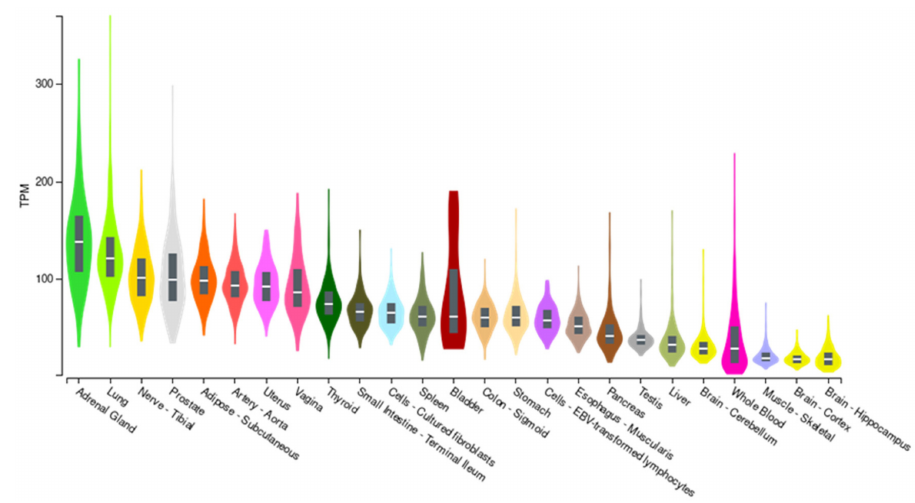
Figure 2. CD46 expression in different tissues (GTEX portal). TMP: Transcripts per million reads.